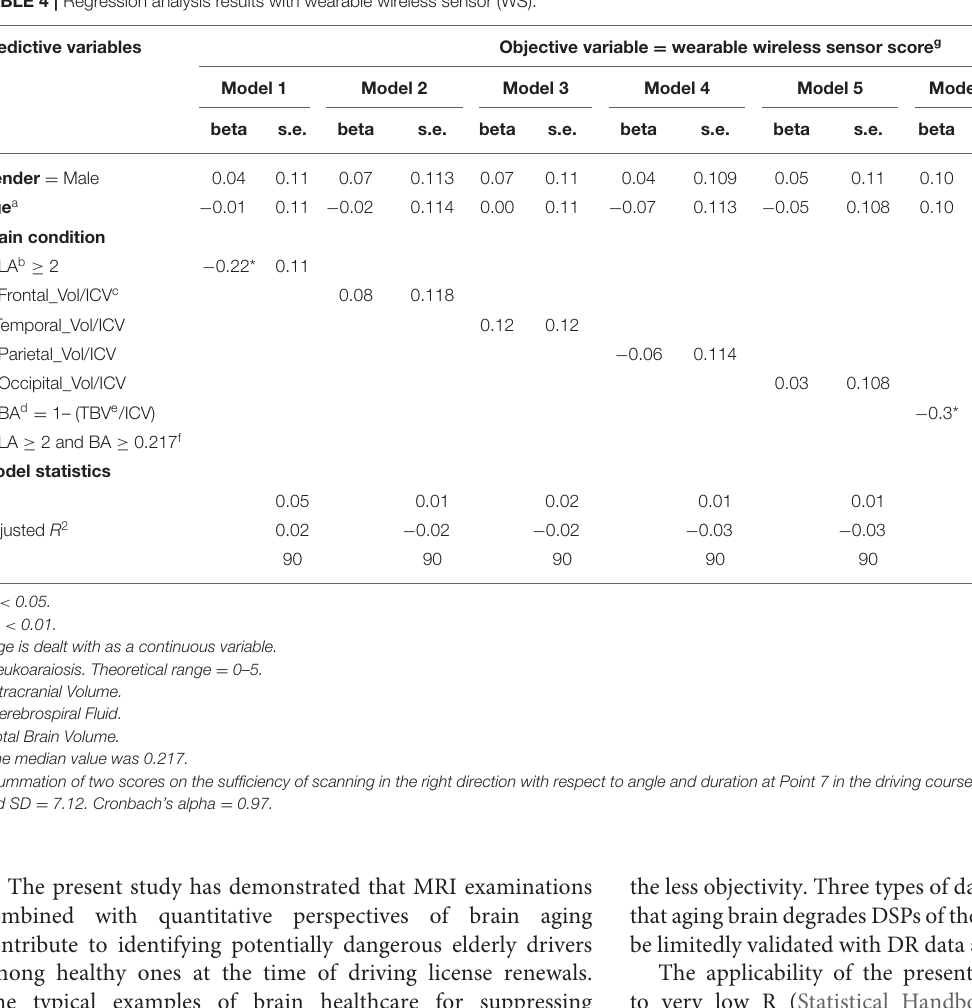
TABLE 4 | Regression analysis results with wearable wireless sensor